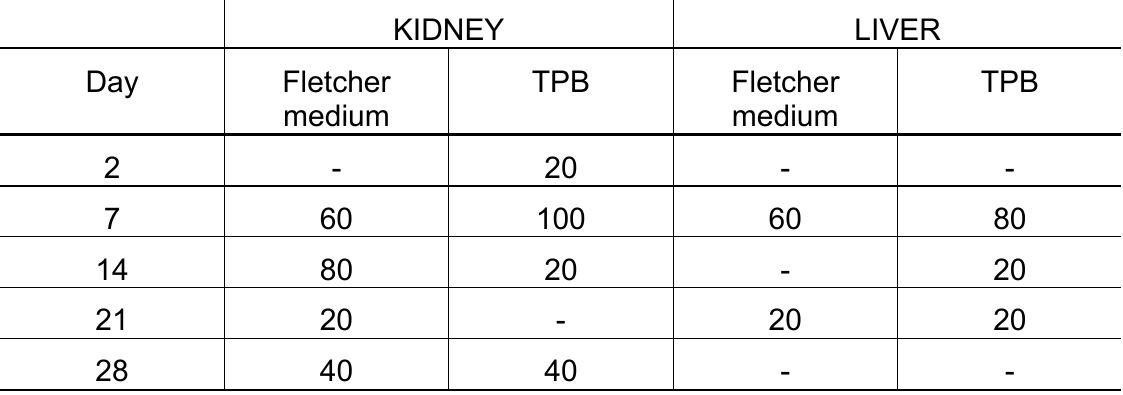
Table 1. Recovery of Leptospira interrogans serovar Canicola from kidney and liver fragments in Fletcher medium or Tryptose-Phosphate-Broth (TPB). Values were expressed as